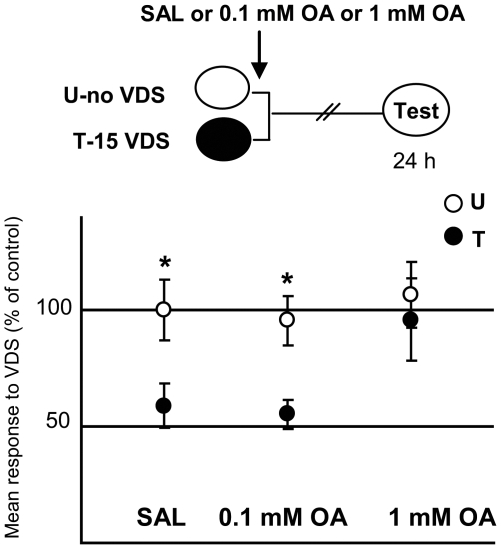
OA impairs aversive memory in a dose-dependent way.(Upper diagram): Experimental protocol. Training session (Day 1): white oval stands for U groups and black oval for T groups that received 15 VDS presentations. Three U–T pairs: SAL (N = 35 per group), 0.1 mM OA (N = 35 per group), and 1 mM OA (N = 35 per group), injected immediately after the 15th training trial (arrow). Testing session: white oval with the word “Test” inside performed 24 h later. (Lower panels): Results of the Testing session for the three U–T pairs. Mean response to the VDS and S.E.M (standard error mean) normalized with respect to the mean response of the U-SAL group. White circles for U groups and black circles for T groups. * stand for p<0.05, (T<U memory retention).